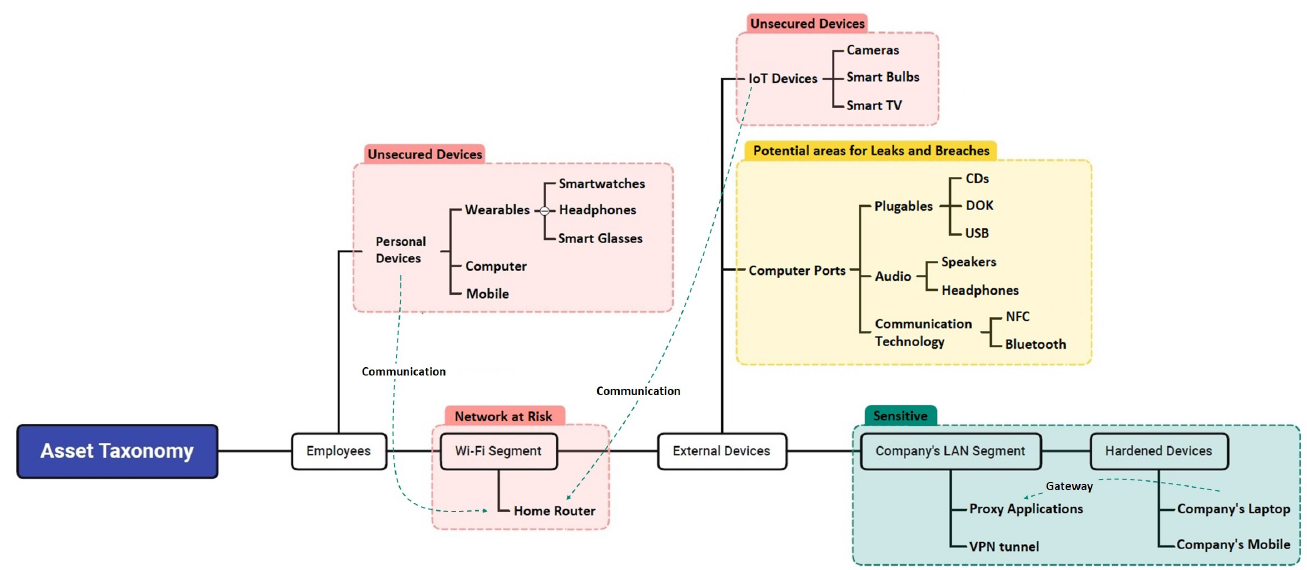
Figure 1. Asset taxonomy.